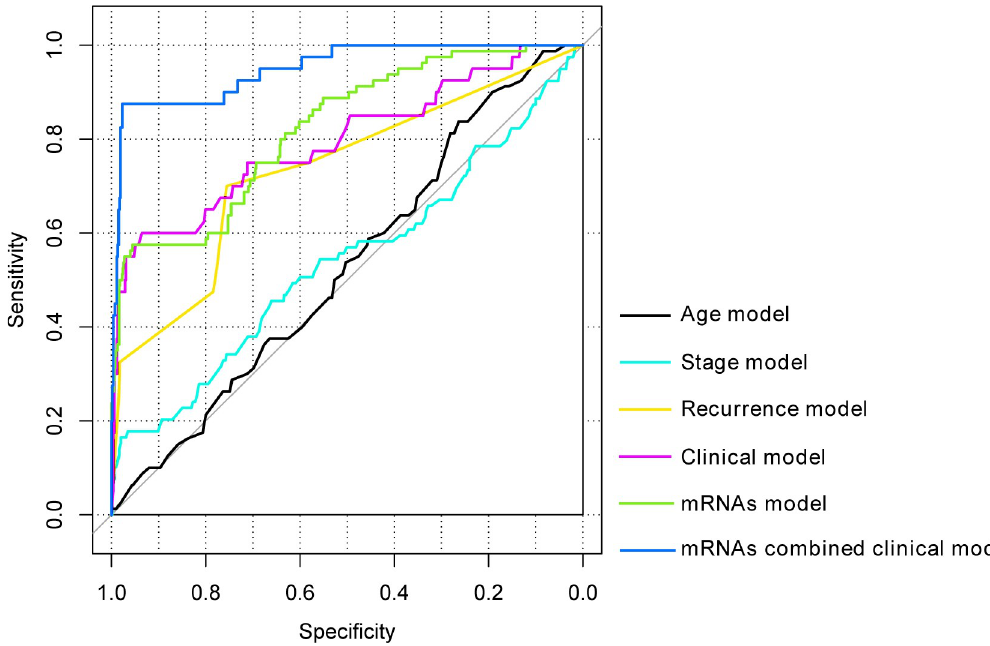
Fig 6. ROC curve comparison based on different models. ROC, receiver operating characteristic. The clinical model contains the factors of age, pathologic, and recurrence.